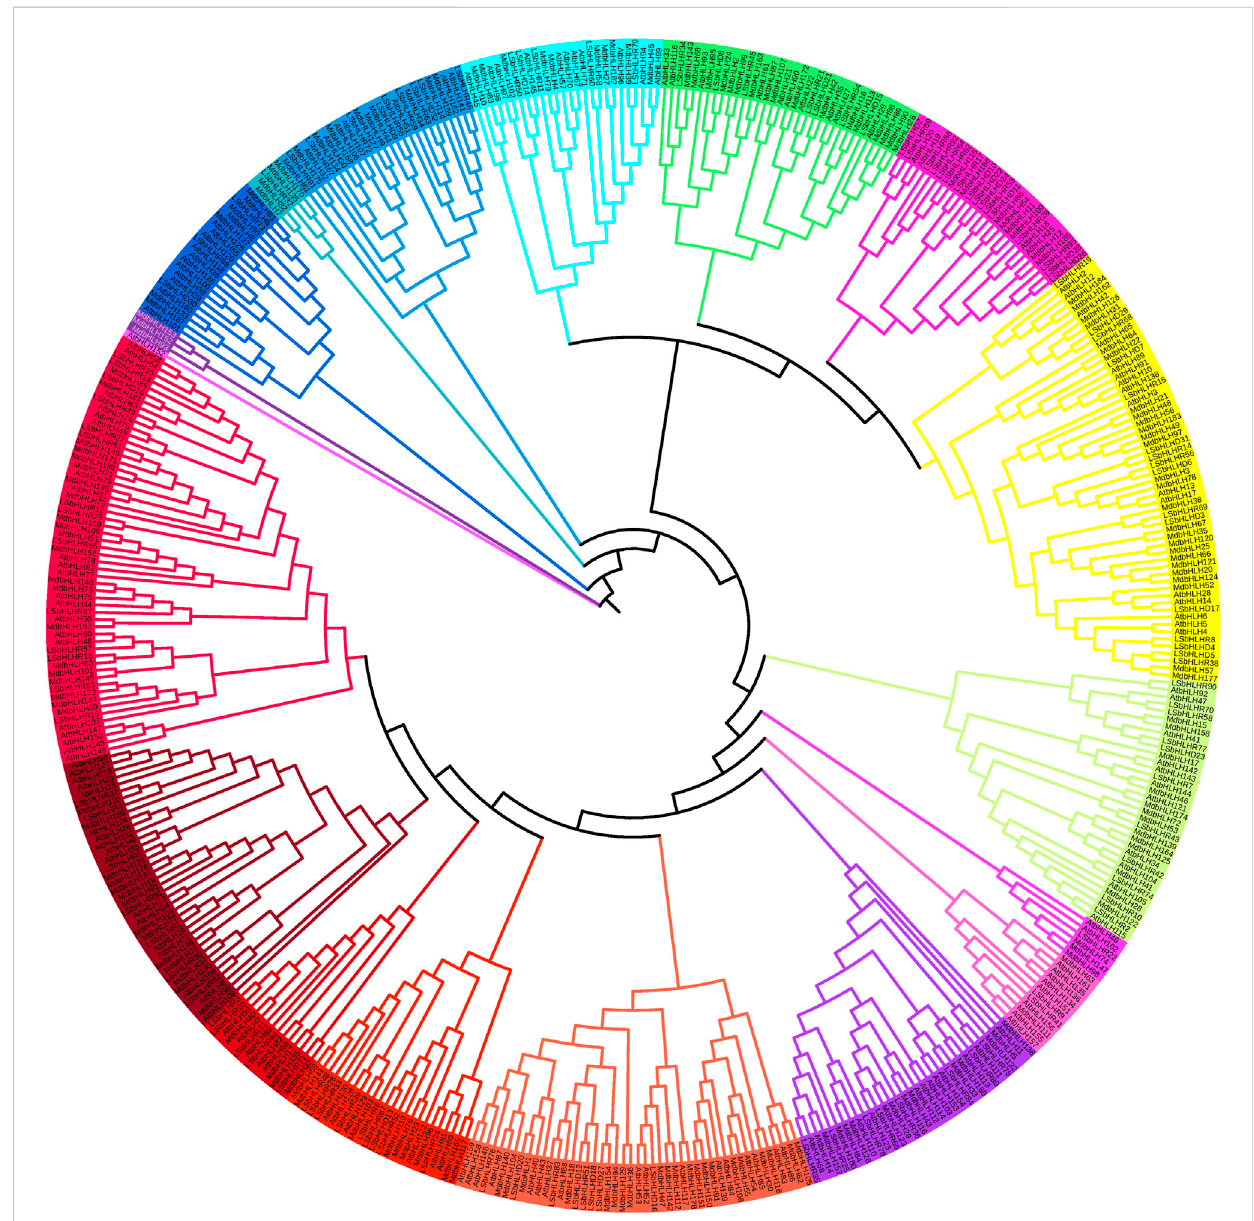
FIGURE 1 Phylogenetic tree of bHLH protein domains from Arabidopsis thaliana , Manus domestica , and grass pea. The tree was generated using the MUSCLE and RAXML algorithms, and the Maximum Likelihood method was employed with the best bootstrap replicates. The tree displays the 18 subfamilies, which are marked with distinct